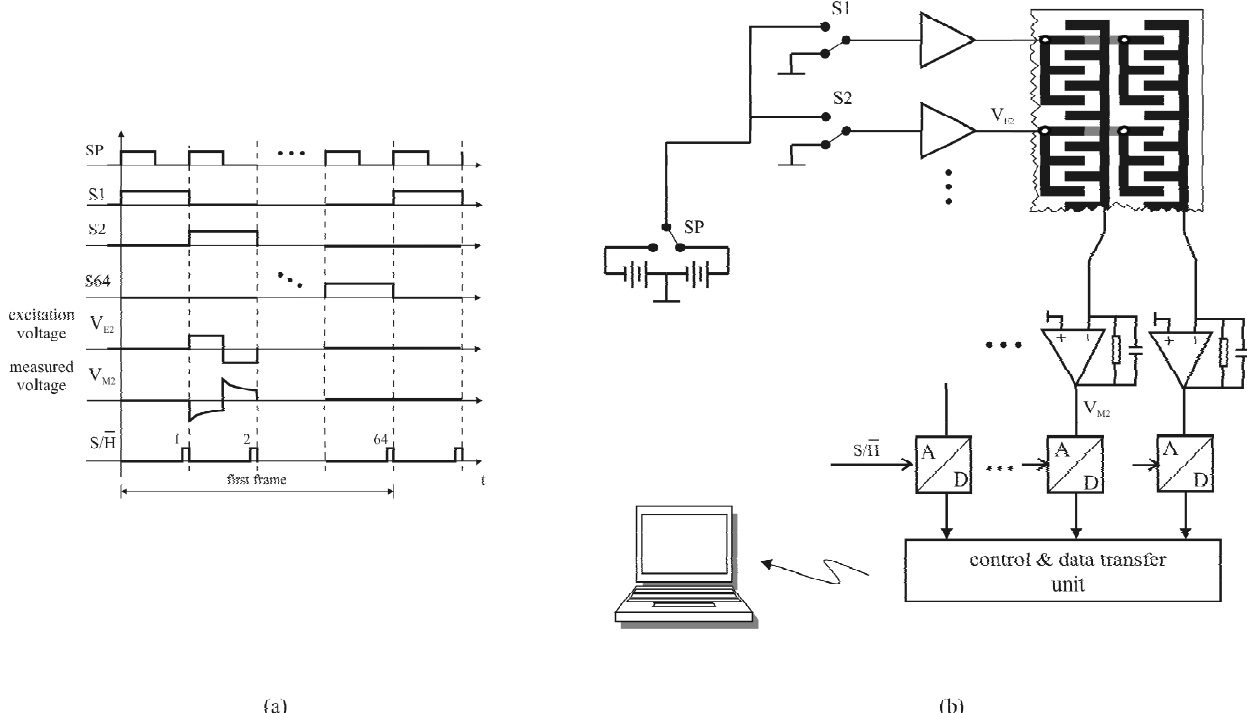
Figure 2 . (a) Timing diagram for the multiplexed excitation and measuring scheme for the sensor. The signal SP denotes the polarity switch and S1 to S64 the analog switches. Voltages are sampled at the rising edge of the sample-and-hold signal. One frame is complete when the 64 transmitter electrodes have been activated and all currents have been measured. (b): Block diagram of the measuring